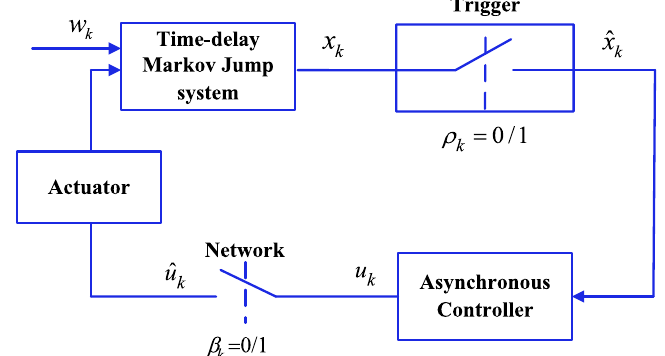
Fig. 1 Event-triggered asynchronous control with packet